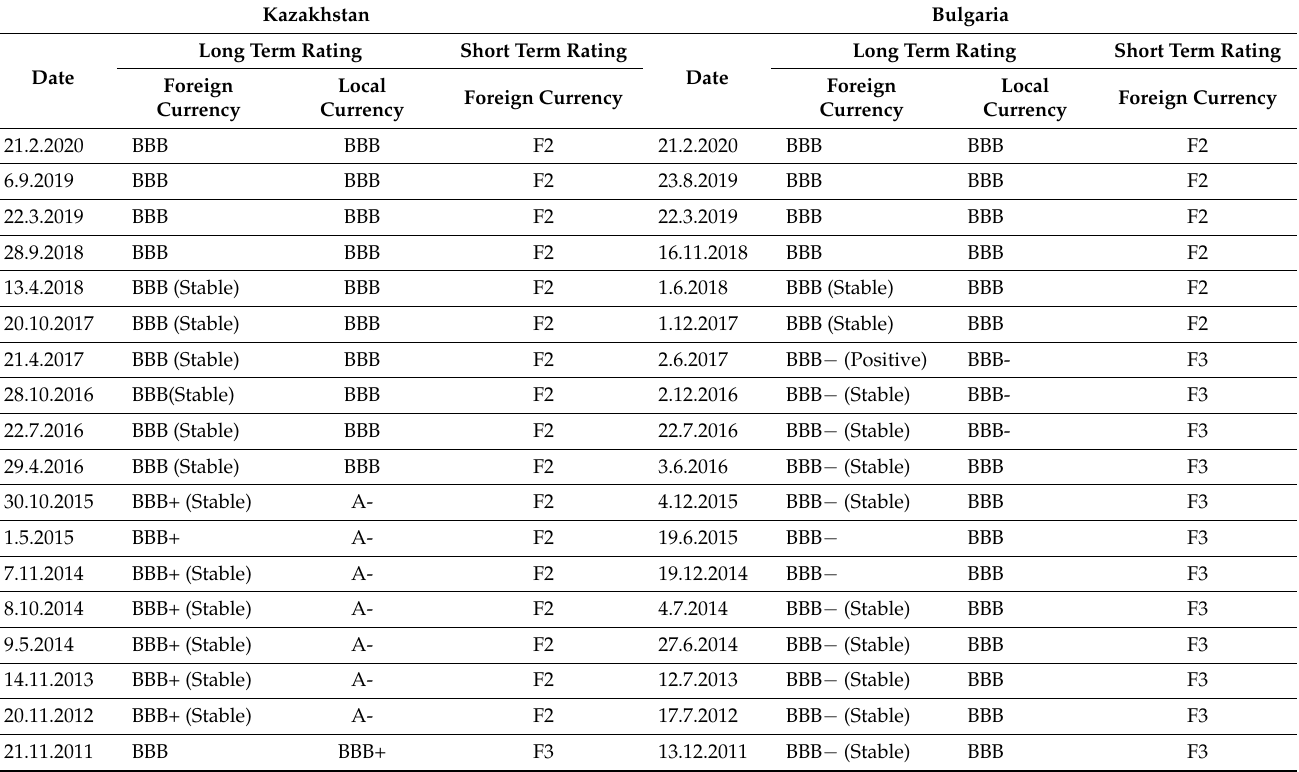
Table 9. Fitch’s sovereign ratings for Bulgaria and